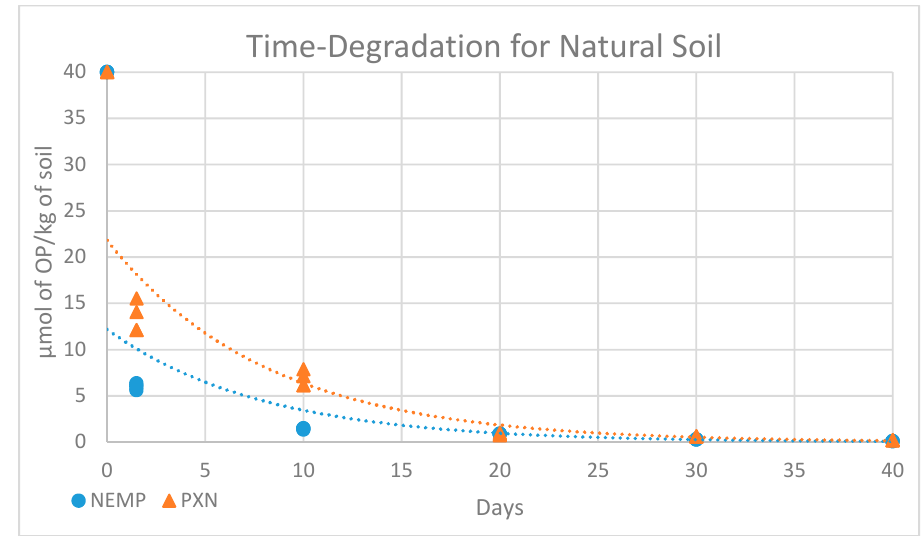
Figure 12. Experimental results for degradation in time of NEMP and PXN in natural soil sample. Table 7. Values with intervals for 95% of confidence obtained in natural soil (µmol of OP/kg of soil).